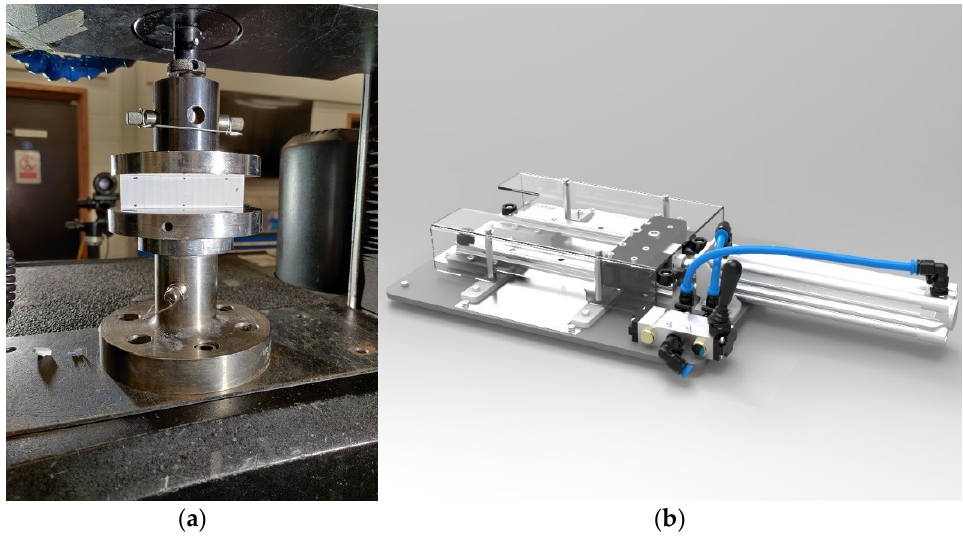
Figure 4. Edge crush test: ( a ) Universal Testing Machine (Instron 5569); ( b ) FEMAT lab device.